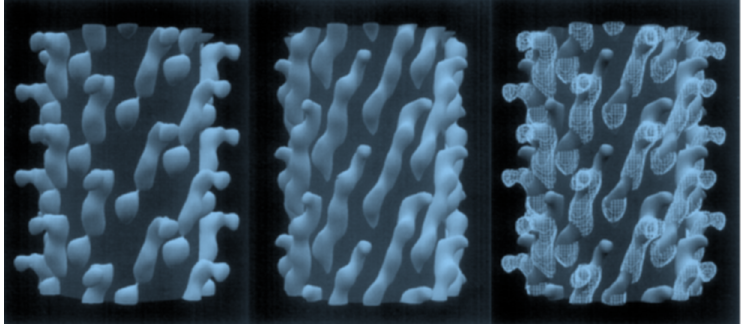
Figure 5. Configuration of a 5-mer peptide displayed on bacteriophage (phage) M13. Computer rendering of a ~10 nm length of the surface of electron density maps of M13 ( left ), fusion phage with 5-mer peptide inserted in all copies of p8 proteins ( center ), and a rendering of the differences between images ( right ). A cylinder of 2.5 nm radius was added to images to mask essentially identical interior features of the phages. About half of each coat protein is visible in phage surface images. Adapted from [48].